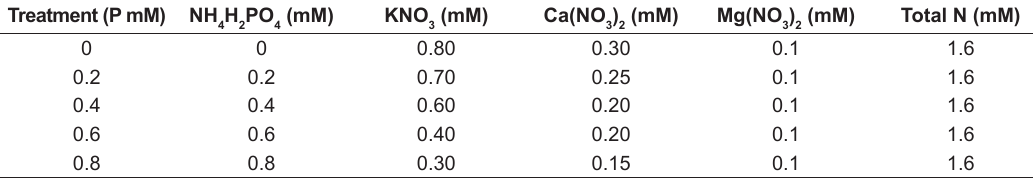
Table 1. Concentrations of P and N sources in the nutrient